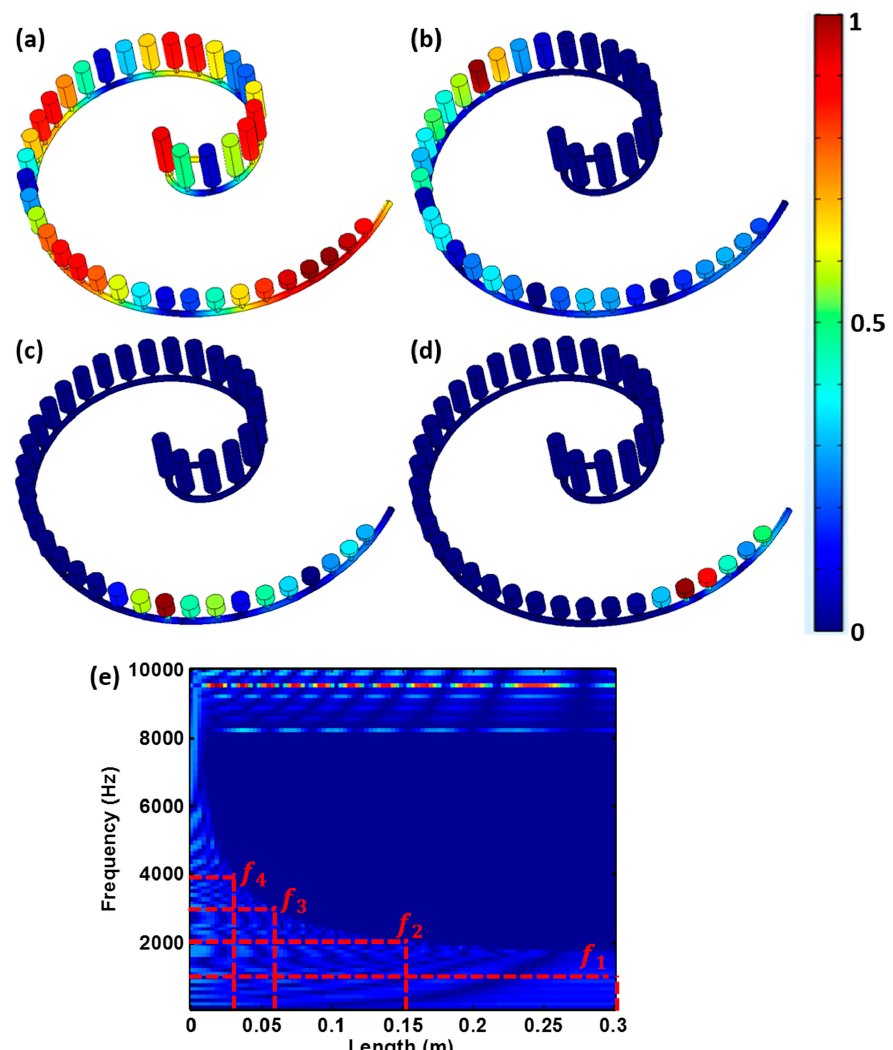
Figure 3. Normalized acoustic pressure in the spiral structure with Helmholtz resonators for ( a ) f 1 = 1 kHz, ( b ) f 2 = 2 kHz, ( c ) f 3 = 3 kHz, ( d ) f 4 = 4 kHz, and ( e ) normalized pressure amplitude (brighter spots indicate higher values) for each frequency along the central axis of the spiral tube.